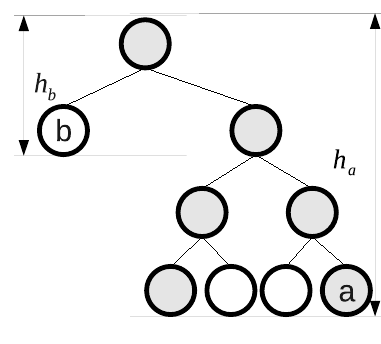
Fig. 2. Unbalanced key